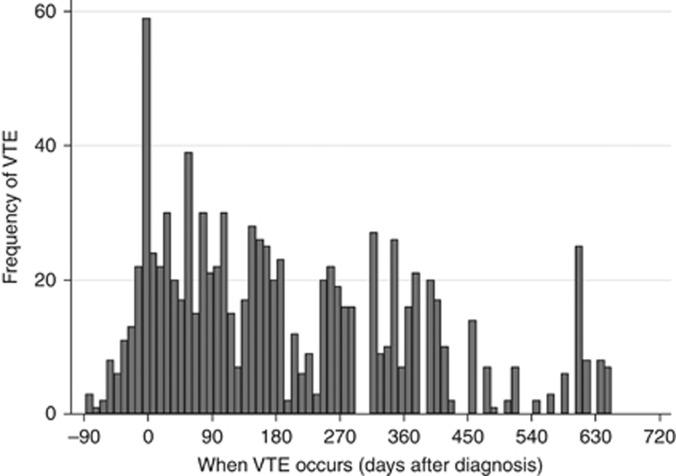
Histogram to describe the frequency of VTE occurrence over the first 2 years after diagnosis (time 0 is the date of diagnosis).